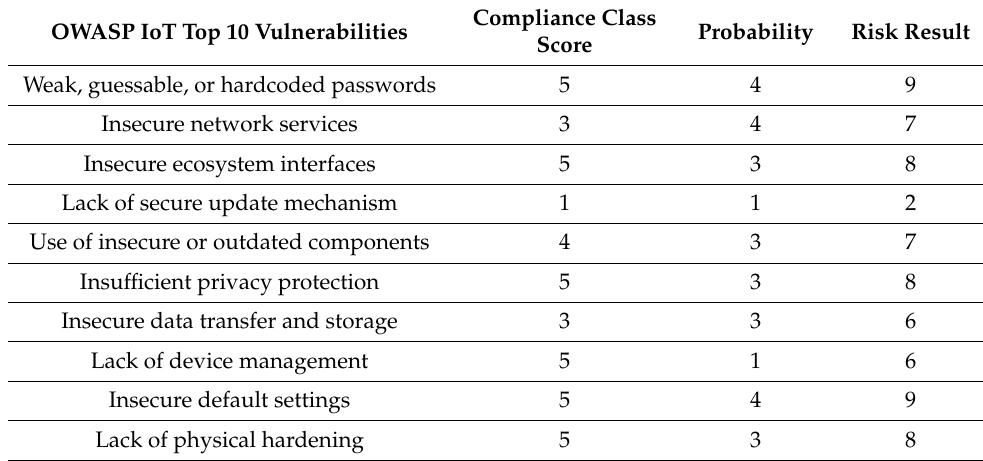
Table 13. Case study risk.